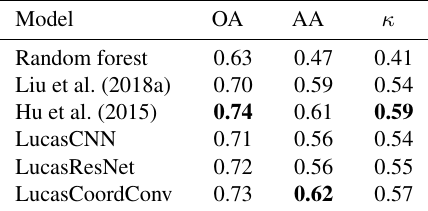
Table 2. Classification results based on the test